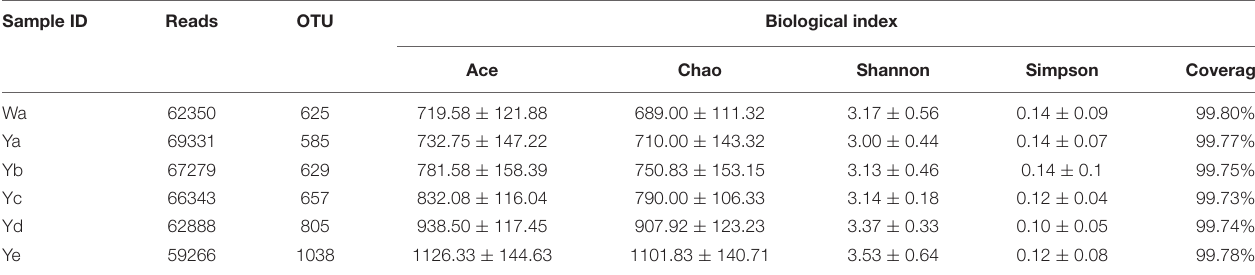
TABLE 1 | ACE, Chao1, Shannon, and Simpson indices of intestinal bacteria in different groups of